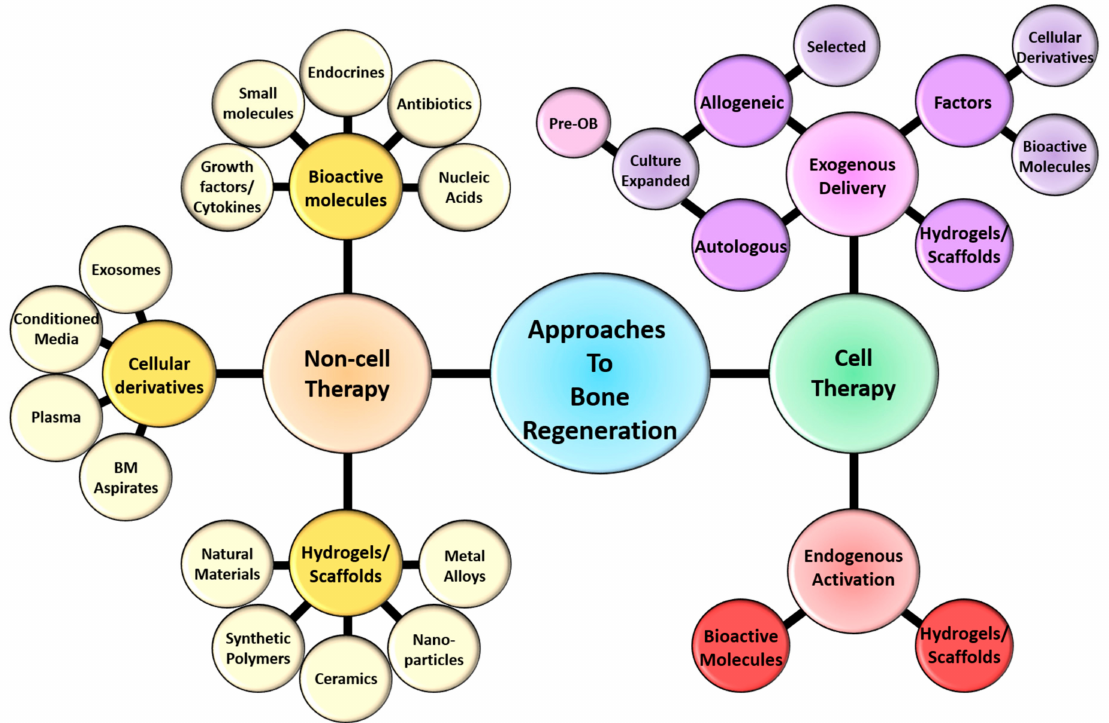
Figure 1. Schematic representation of the current approaches to bone regeneration. Non-cell therapy approaches to bone regeneration encompass bioactive molecules cellular derivatives and hydrogels / sca ff olds / implantsthatcaninteractwithandregulate / influencecellularresponses. Celltherapyapproach comprise the delivery of exogenous cells, either autologous or allogeneic in combination with non-cell therapy approaches. Alternatively the activation of endogenous cells (stem cells, endothelial cells, hematopoietic populations and / or mesenchymal populations) through non-cell therapy approaches have been and are currently being developed to regenerate the appropriate skeletal tissue. The bioactive molecules include a range of growth factors / cytokines, small molecules / drugs, endocrines / hormones, antibiotics and nucleic acid / genetic manipulation. The cellular derivatives incorporate components that have been derived from cells within the bone, these include exosomes, conditioned media, plasma / platelet rich plasma (PRP) and aspirates from the bone marrow (BM). The hydrogels / sca ff olds / implants embodies the fabrication of injectable, microbeads, nanogels, fibers, biofilms, membranes, sponges, bone grafts and solid sca ff olds that are derived from either natural materials, synthetic polymers, ceramics, nanoparticles, metal alloys or composites of these components. These bio-compatible hydrogels / sca ff olds are also manipulated to incorporate and deliver cells, cellular derivatives and / or bioactive molecules in a temporal and spatial manner to enrich bone